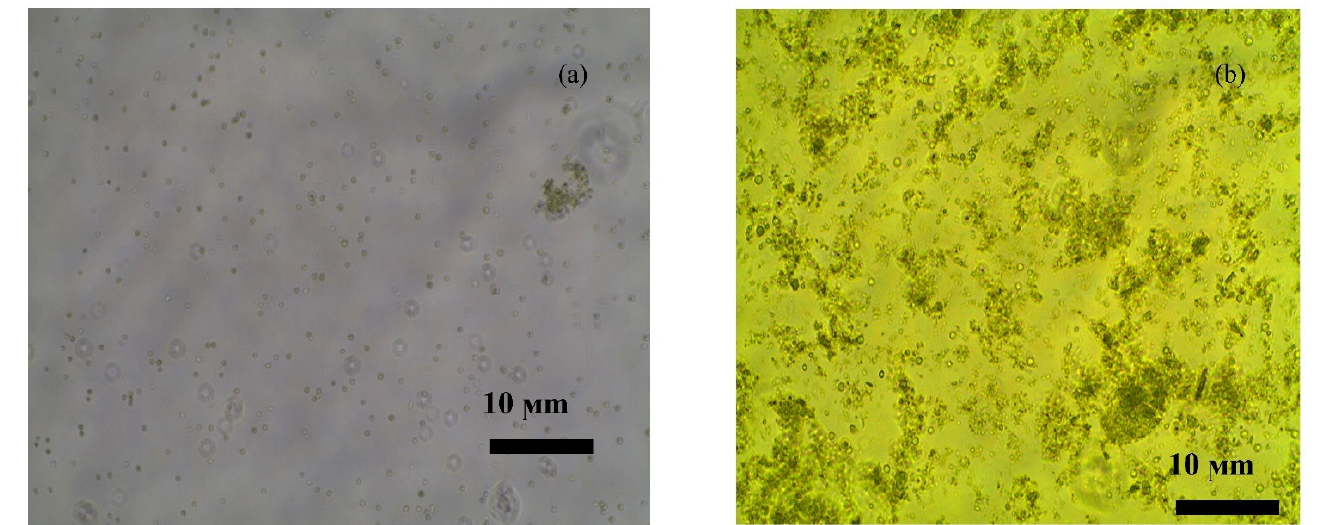
Figure 2. Microscope image of the freshwater microalgae species, Chlorella vulgaris at × 40 magnification ( a ) before and ( b ) after treatment with a foam column.